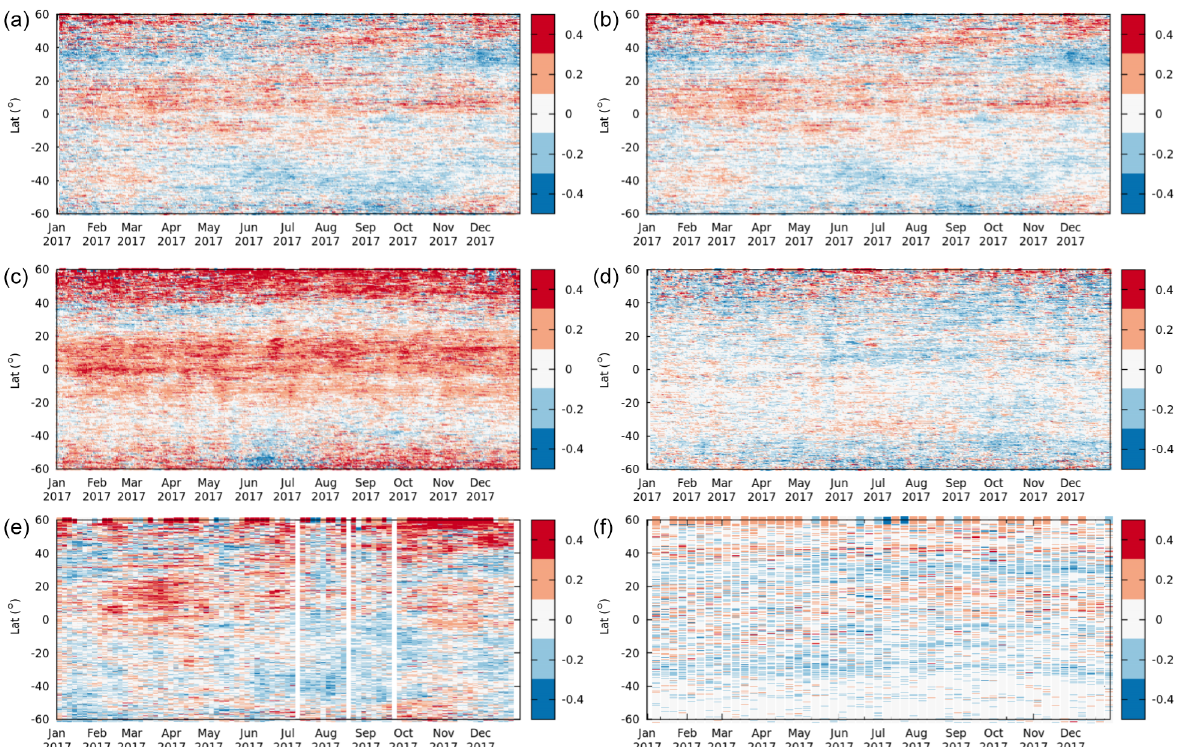
Figure 8. Hovmöller diagrams of the mean difference between salinity gridded products and the temporally and spatially collocated upper- most salinity measurement provided by Argo floats. The y axis represents the latitudes: differences are averaged in latitude bins of 0.25 ◦ . The x axis represents the time (in days): only the year 2017 is considered in this analysis. The gridded products used in this analysis are the following ones: (from left to right and top to bottom) BEC HR, BEC LR, JPL, REMSS, CATDS, and